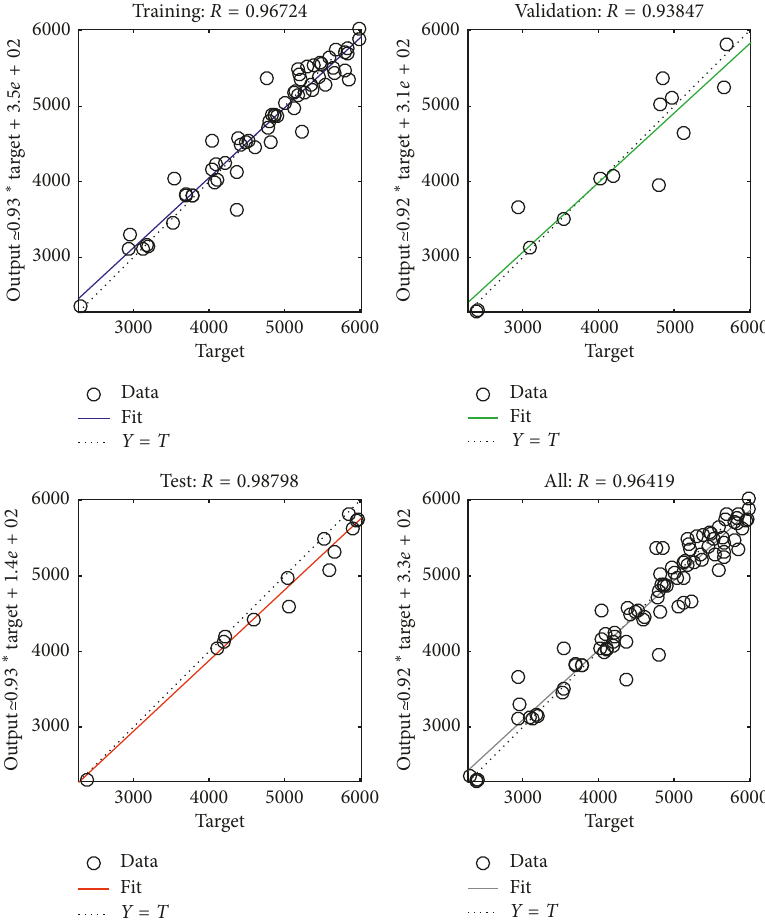
Figure 8: Training, validation, testing phases, and all data for the stiffness modulus (MPa) ANN